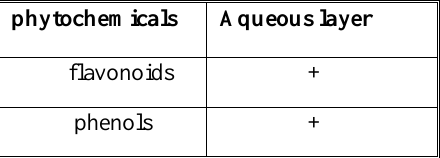
Table 1. Preliminary examination of the aqueous fraction for phenols and flavonoids.